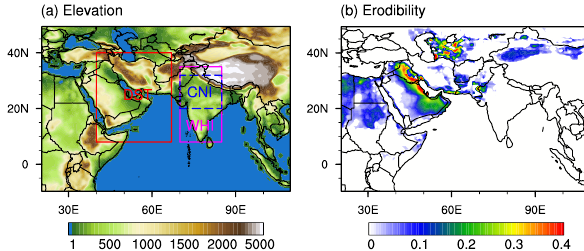
Figure 1. (a) Elevation map in WRF-Chem domain (unit: m). “DST”, “WHI”, and “CNI” represent the remote dust region (8 ◦ – 40 ◦ N, 40 ◦ –67 ◦ E), the entire India (8 ◦ –35 ◦ N, 70 ◦ –85 ◦ E), and central and northern India (20 ◦ –32 ◦ N, 70 ◦ –85 ◦ E), respectively. (b) Soil erodibility (unitless) map used in WRF-Chem dust emis- sions